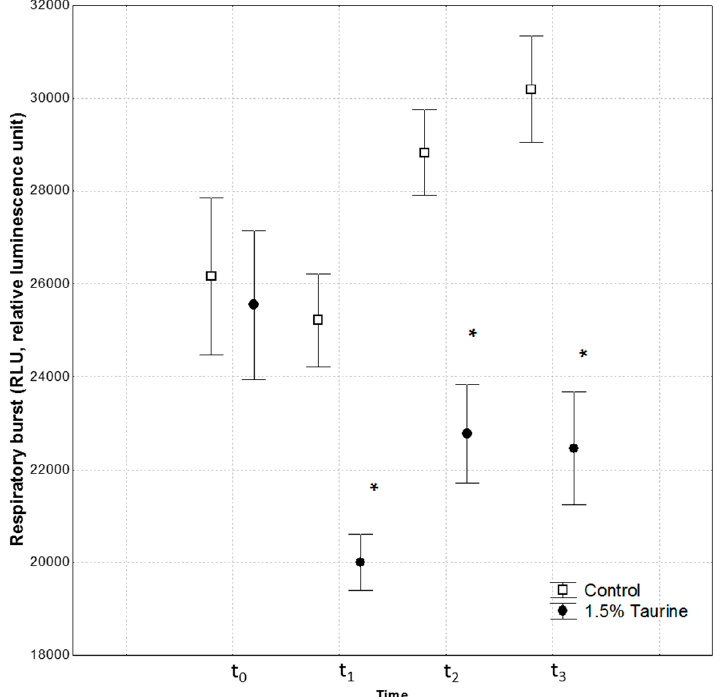
Figure 2. The RBA values after PMA stimulation in blood leucocytes of European seabass fed with control or with the 1.5% Tau-supplemented diet (mean ± SEM, n = 5 fish/diet). (*) means significant differences between dietary groups ( p < 0.05) at t 1, t 2, and t 3 . No interaction between times (t) was detected.